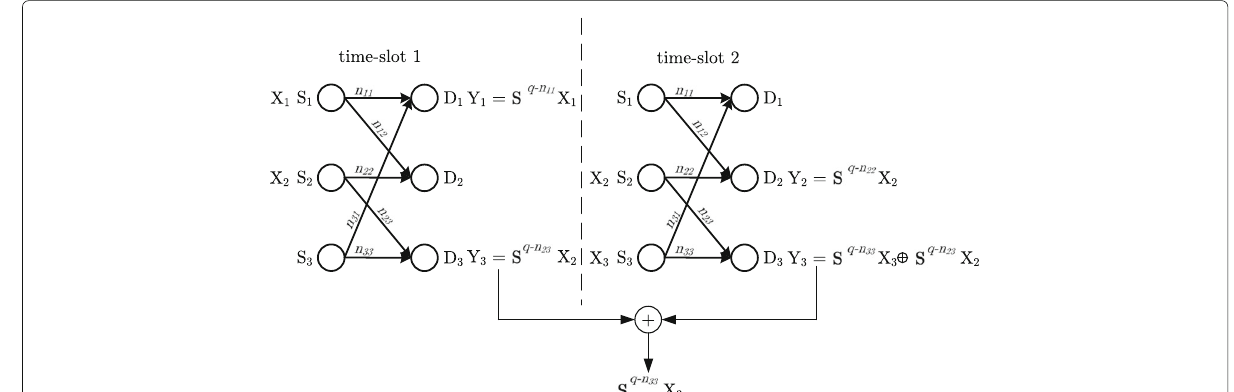
Fig. 3 Achievability strategy for the network depicted in Fig.